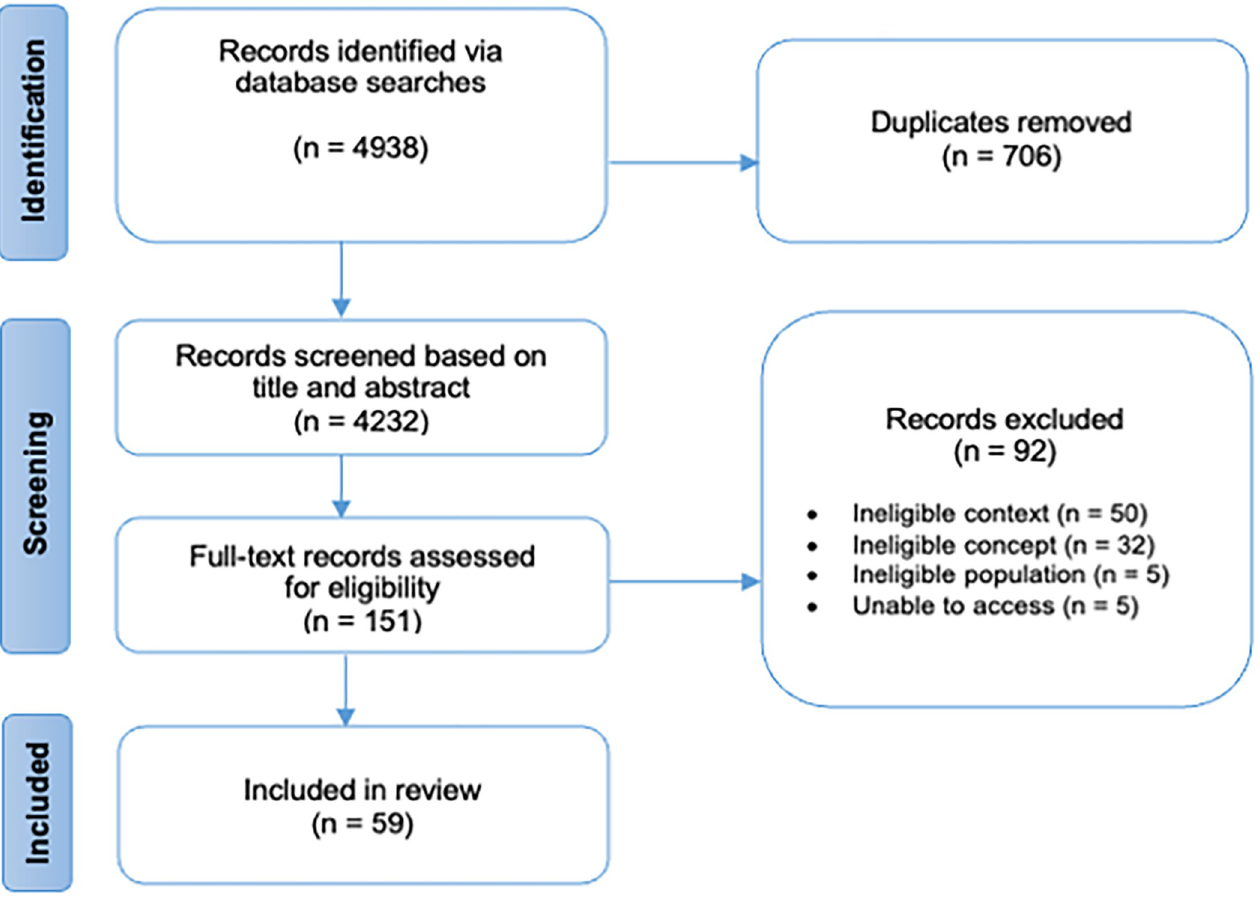
Fig 1. Search results and study selection and inclusion process